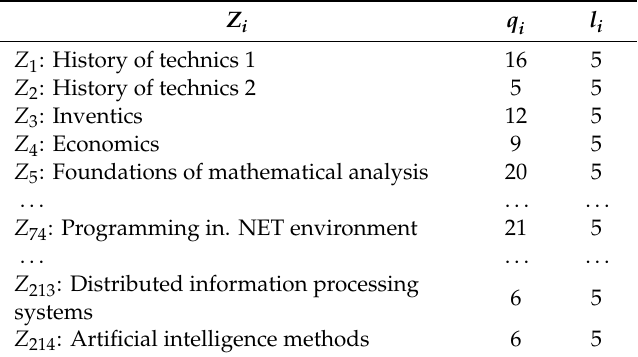
Table 5. Faculty of Electronics and Computer Science (FECS) syllabus.